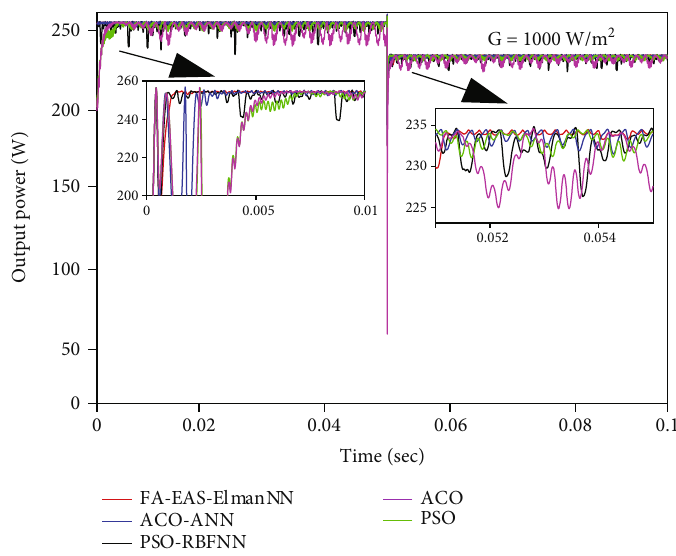
Figure 17: MPPT curve under rapidly decreasing T ( G = 1000 W/m 2 ).